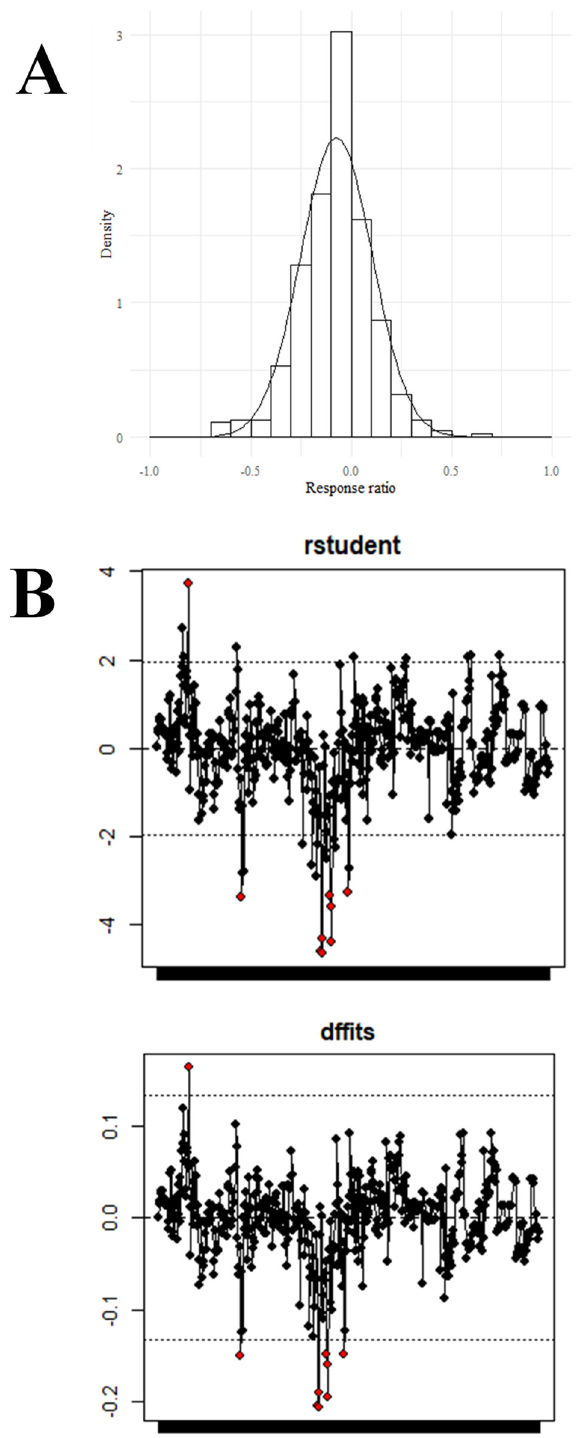
Figure 1. ( A ). Histogram of the effect size represented by the response ratio “RR” (Hedges et al., 1999). ( B ). representing influence and outlier analyses. The externally standardized residuals “rstudent” showed study residuals were normally distributed within the two dotted lines. While “diffits” values showed how many standard deviations the predicted average effect for the ith study changes after that study is left out.